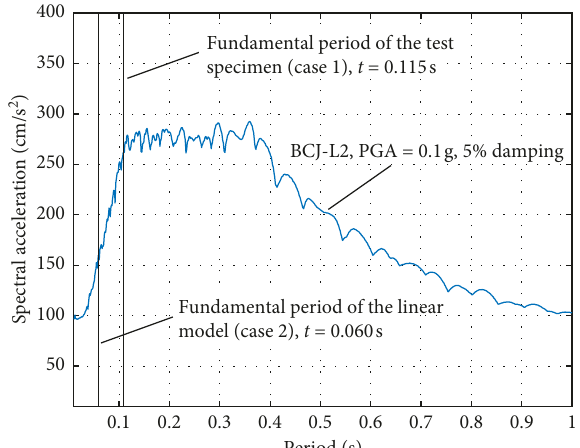
Figure 4: Spectral acceleration of the scaled BCJ-L2 wave and the fundamental period of Case 1 and Case 2.